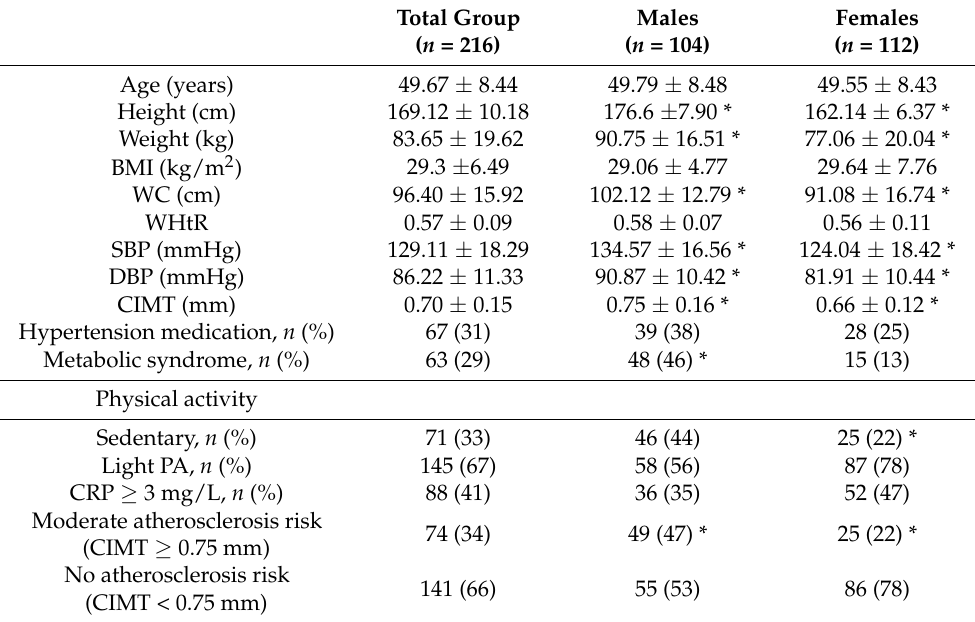
Table 1. Differences in descriptive characteristics of an ethnic sex cohort.